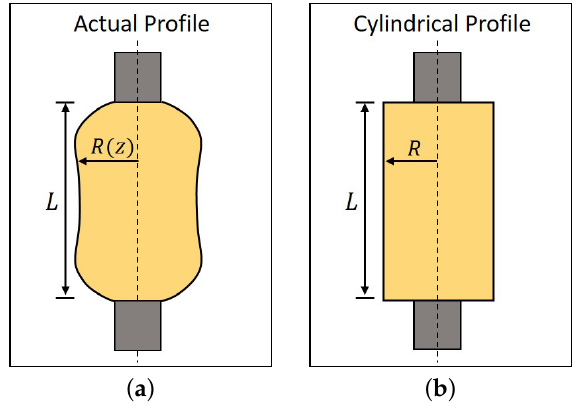
Figure 3. Comparison of PAM shape profiles: ( a ) Actual shape profile, with varying radius along its length. ( b ) The cylindrical approximation profile that is commonly assumed, with constant radius along its